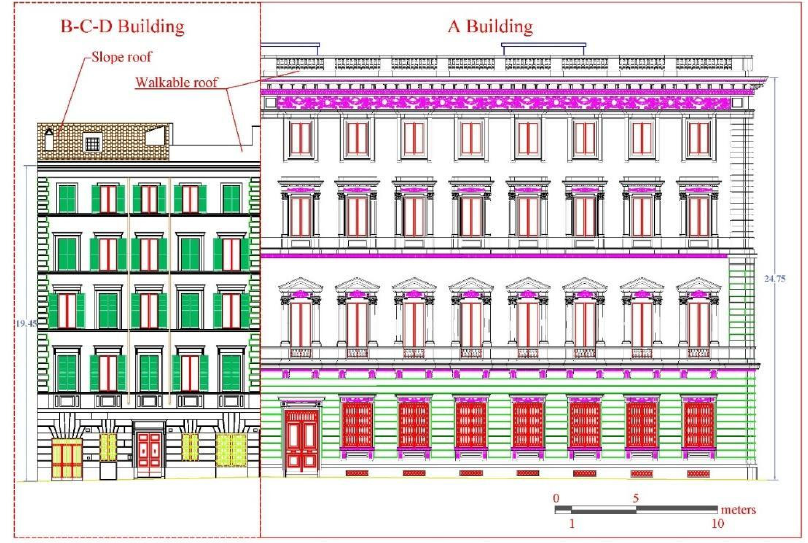
Figure 2. Building